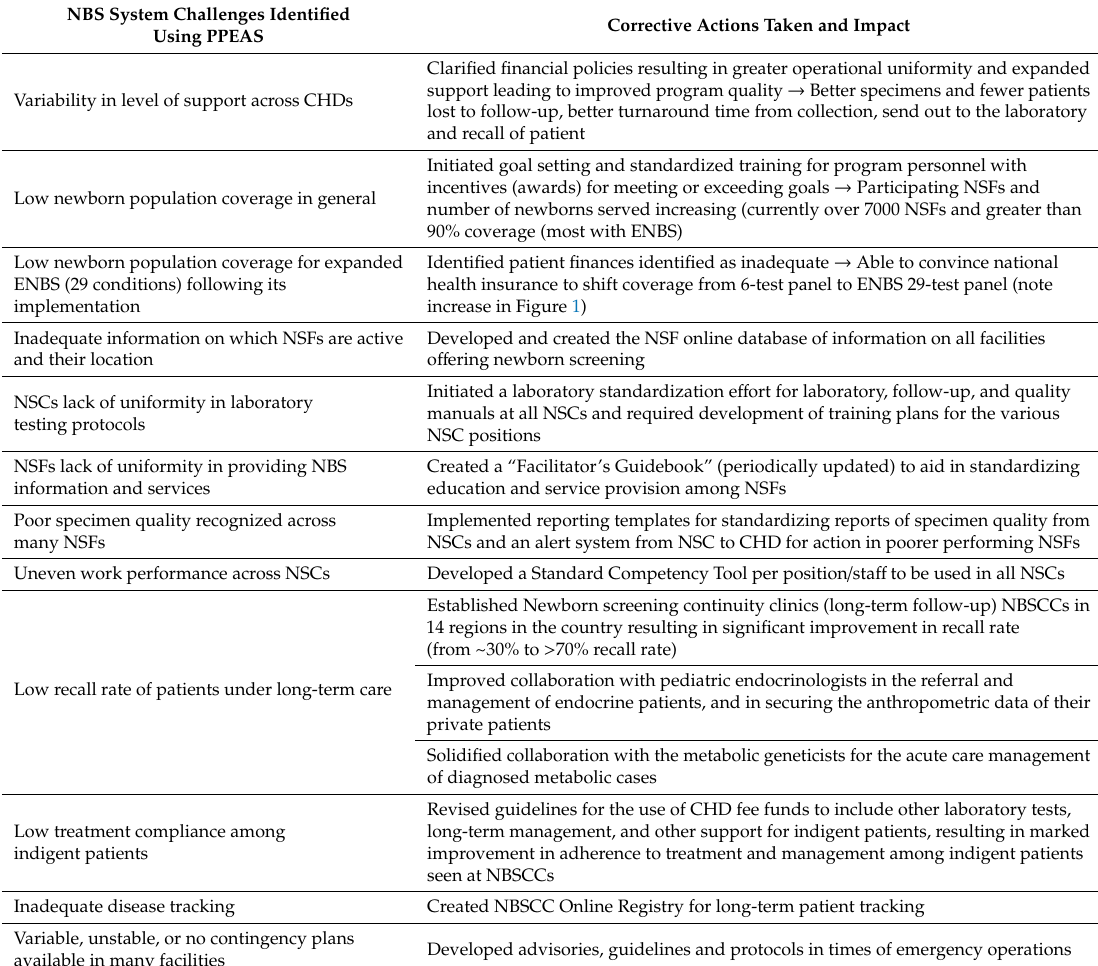
Table 3. Partial listing of challenges for NSRC identified through PPEAS and the resulting actions taken for quality